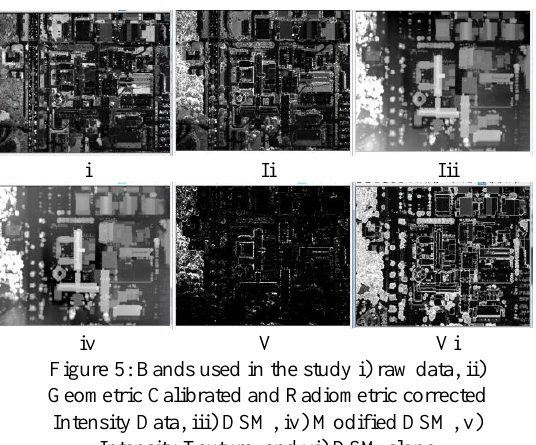
Figure 5: Bands used in the study i) raw data,